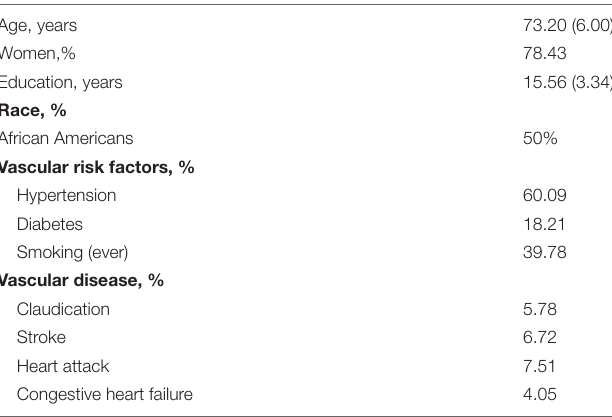
TABLE 2 | Clinical characteristics at study baseline ( N = 1,160).